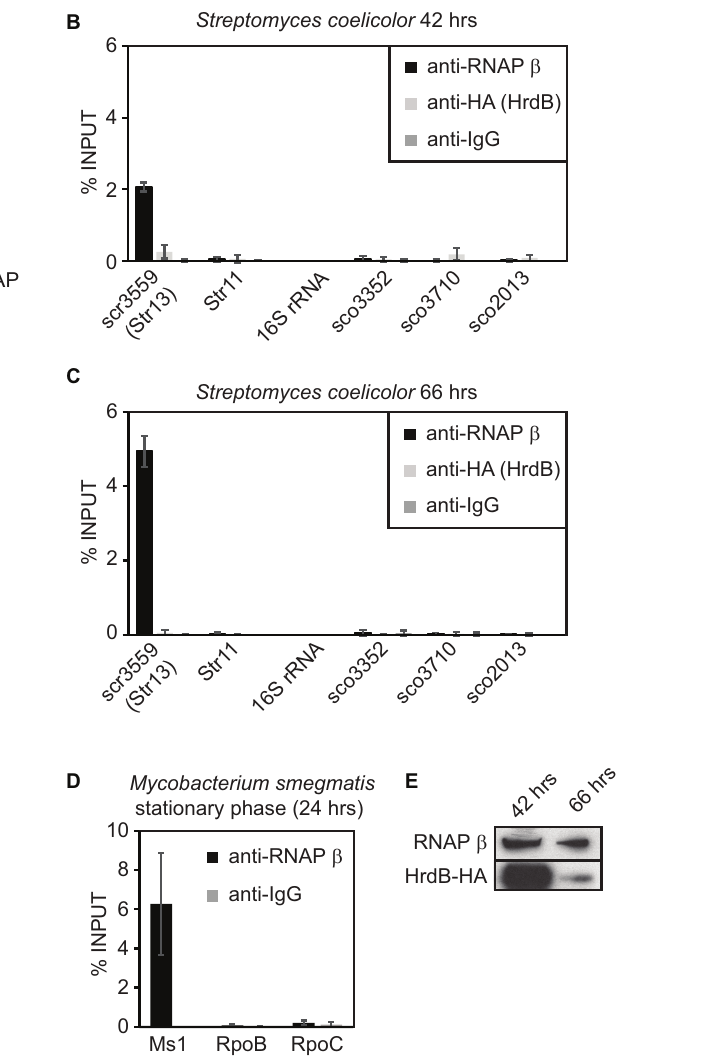
FIGURE 3 | Immunoprecipitation of S. coelicolor RNAP β and HA-HrdB (A–C) and M. smegmatis RNAP β (D) . Lysates from S. coelicolor cells carrying HA-tagged HrdB (42 and 66 h after germination, exponential and stationary phase of growth, respectively) were incubated with antibodies against RNAP β , sigma 70 and HA tag and immunoprecipitated proteins were resolved on SDS PAGE and stained with Coomassie (A) . RNA that co-immunoprecipitation with RNAP or HrdB was isolated, cDNA was reverse transcribed and the amount of Ms1 and 6S RNA candidates were determined by qRT-PCR (B,C) . In S. coelicolor , 16S rRNA and RNAs expressed from sco3352, sco3710, and sco2713 genes were selected as controls that should not bind to RNAP/HrdB. In M. smegmatis , the amount of Ms1 associated with RNAP is shown as a positive control, RpoB and RpoC mRNAs do not co-immunoprecipitate with RNAP (D) . The error bars show ± SEM from at least three independent experiments. The amount of RNAP β and HrdB was measured by western blotting in A3(2) hrdB-HA 42 h (exponential phase) and 66 h after germination (stationary phase) (E) , the same amount of proteins (15 µ g) was